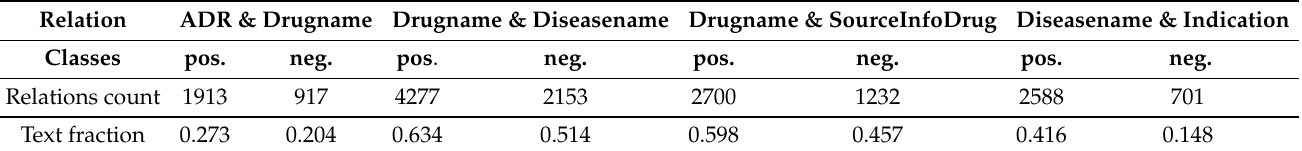
Table 4. Statistics on the types of relations in the RDRS corpus with 908 multi-context reviews.